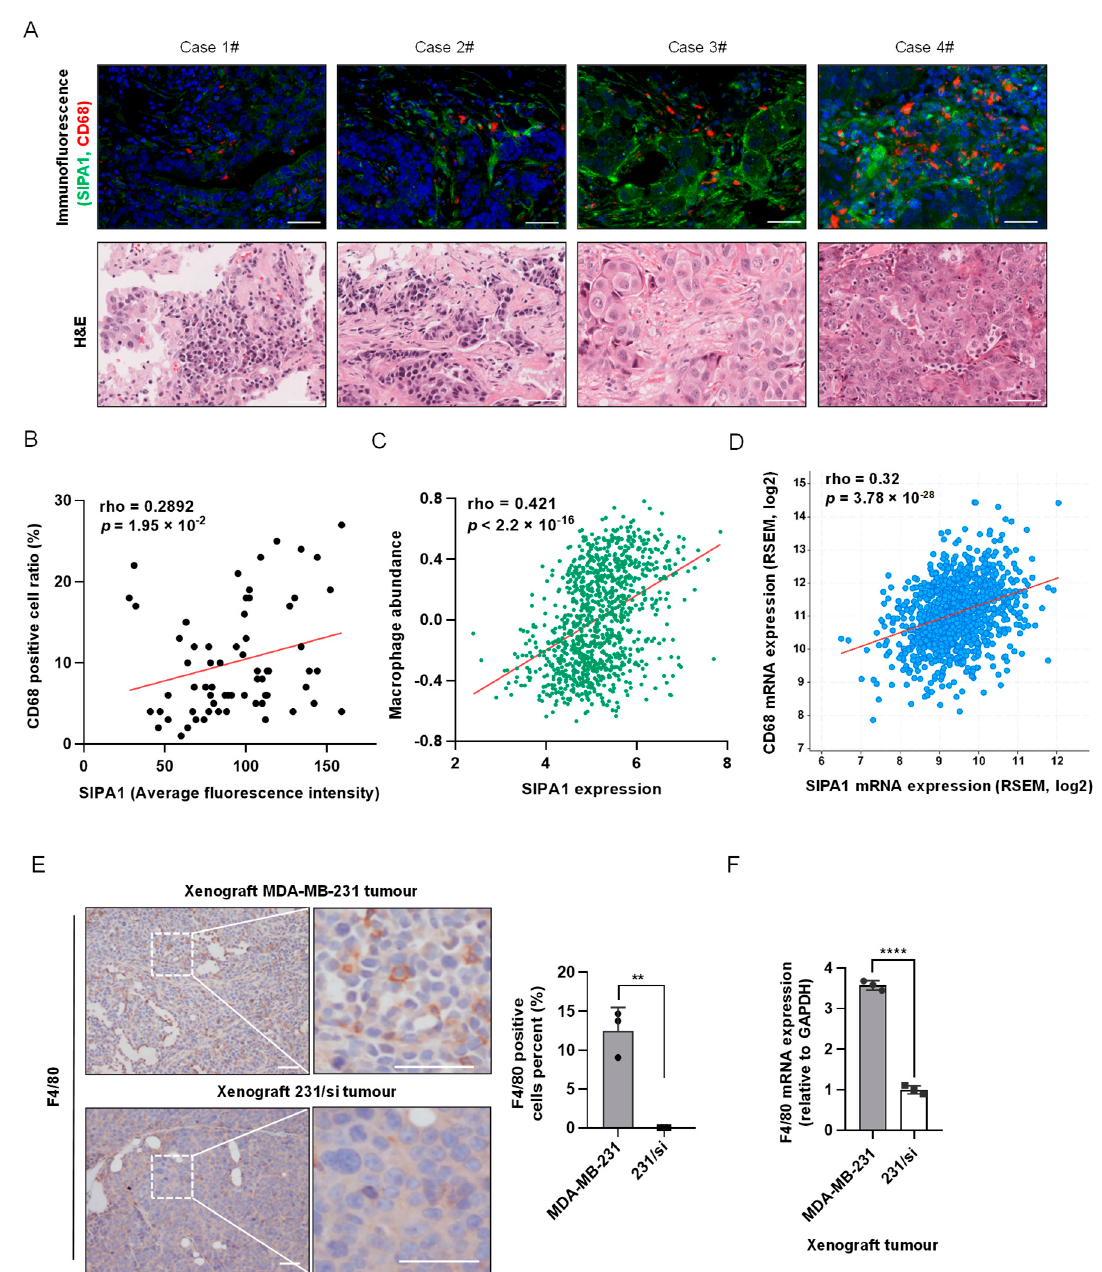
Figure 1. Correlation between SIPA1 expression level in breast cancer tissues and macrophage abundance in tumour microenvironment. ( A ) Immunohistochemical staining of CD68 (red), SIPA1 (green), and 4 ′ ,6-diamidino-2-phenylindole (blue) of the representative breast cancer tissues (upper panels), along with the collative haematoxylin and eosin images (lower panels). Case 1# to Case3#: Grade II; Case 4#: Grade III. Scale bar: 50 μ m. ( B ) The correlation between the percentage of CD68-positive cells (positive cells/total cells, %) and average fluorescence intensity of SIPA1 in tissue microarray (n = 65). ( C ) The correlation between SIPA1 expression and macrophage abundance based on the TISIDB database. ( D ) Co-expression analysis of SIPA1 and CD68 in breast cancer via cBioPortal platform (n = 1100). ( E ) Immunohistochemical analysis (left panel) and quantitative analysis (right panel) of the macrophage marker F4/80 in MDA-MB-231 or 231/si cell xenograft tumours. Scale bar: 50 µ m; ** p < 0.01. ( F ) Determination of F4/80 mRNA levels, normalised to GAPDH, in MDA-MB-231 or SIPA1 -knockdown MDA-MB-231 (231/si) cell xenograft tumours by quantitative real-time PCR (qRT-PCR, n = 3); **** p <